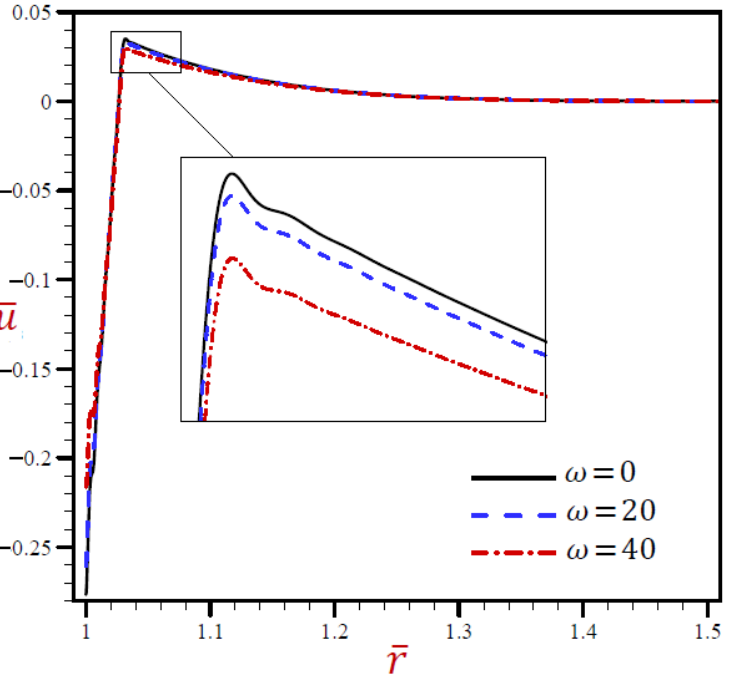
Figure 9. The influence of 𝑡 on radial displacement 𝑢̅ through radial direction of spherical hole using RDPL model.